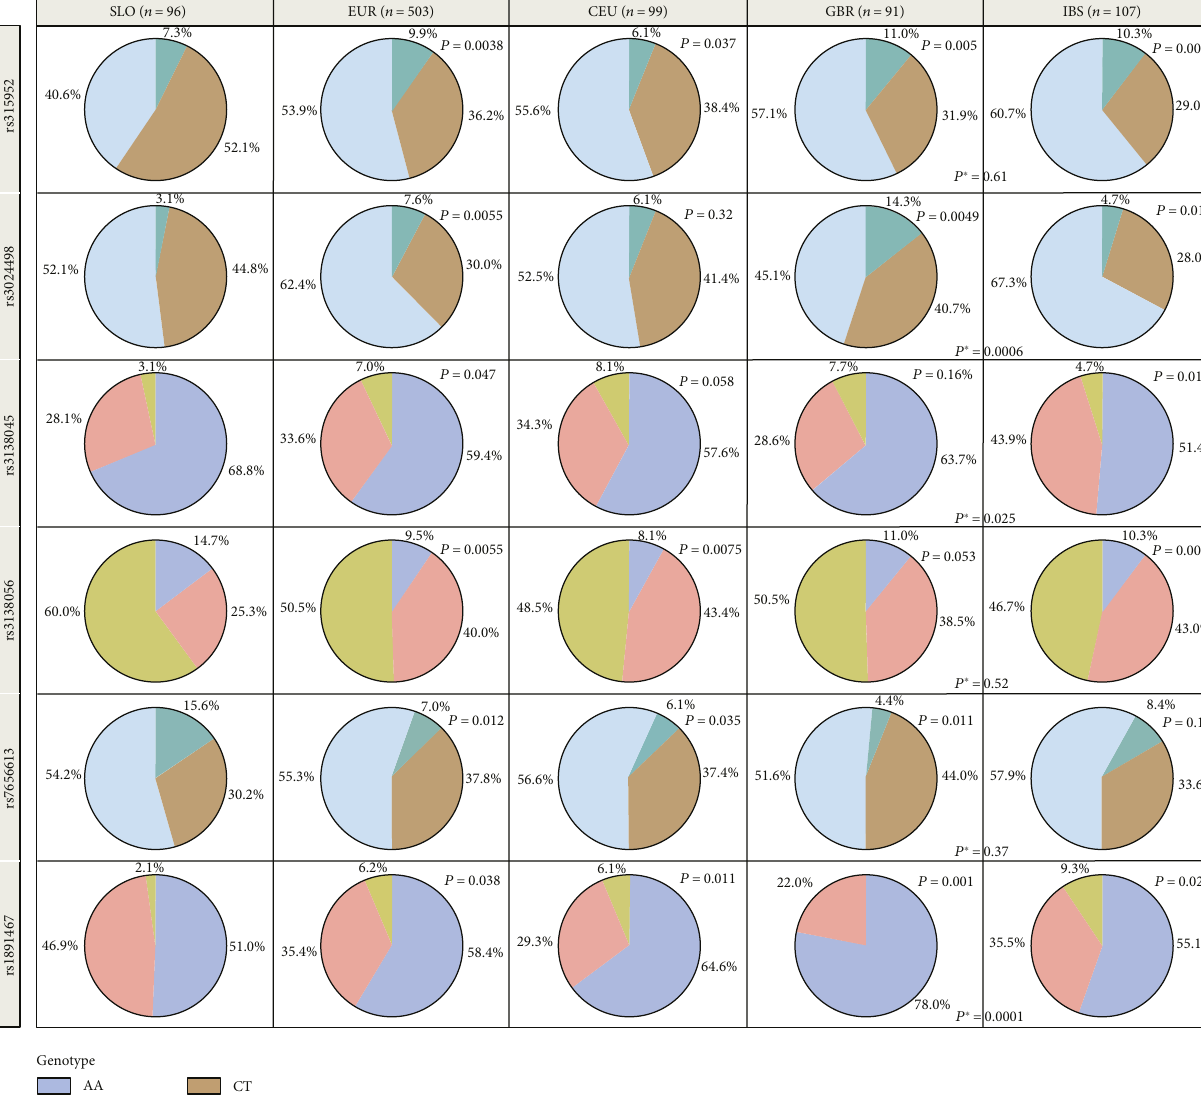
Figure 1: The genotype frequencies for 6 SNPs across European subpopulations. P value means di ff erence in genotype distribution between Slovenian population (SLO) and other populations (EUR, CEU, GBR and IBS). P ∗ value means di ff erence in genotype distribution between Great Britain population (GBR) and Iberian population (IBS)